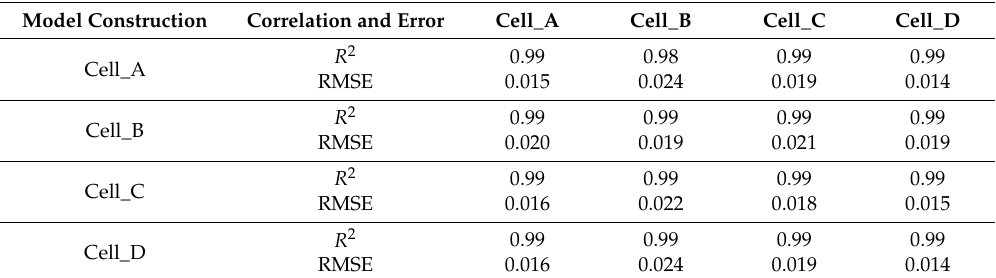
Table 5. R 2 and RMSE of SOC estimations using different cells for model construction.